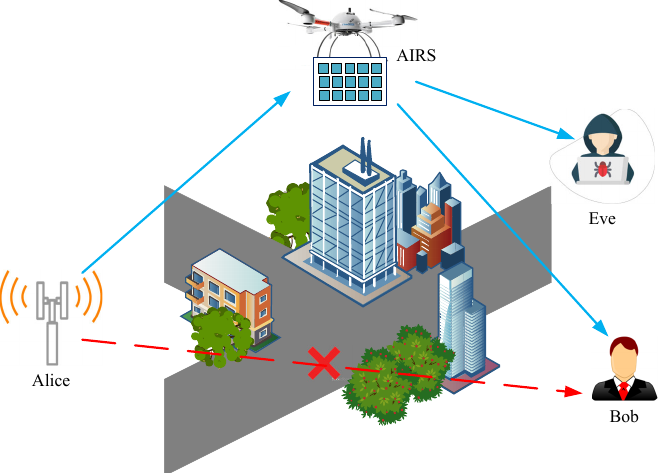
Figure 1. The system model of AIRS-assisted secure communication